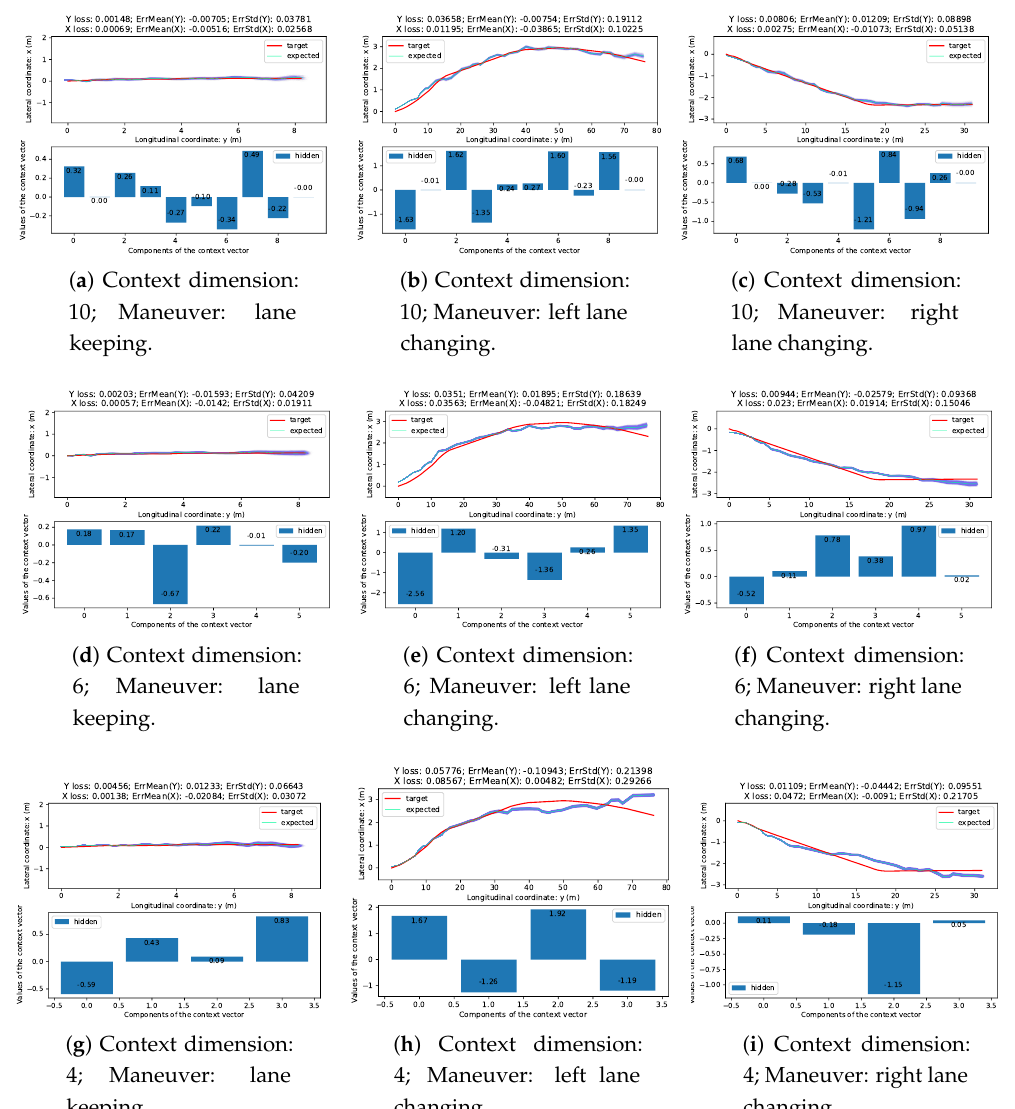
Figure 5. Variational Autoencoder performance on copying the trajectory data without using the traffic information of surrounding vehicles. From top to bottom: Reconstruction with 10-, 6-, and 4-dimensional latent space. From left to right: The same trajectory of a lane-keeping and lane changing on the right and the left, respectively. The red curve is the ground truth; the green one is the most probable reconstruction trajectory. The horizontal axis is the longitudinal y coordinate of the vehicle’s trajectory, and the vertical is the lateral x coordinate. Under the trajectory graphs: The hidden state vector is